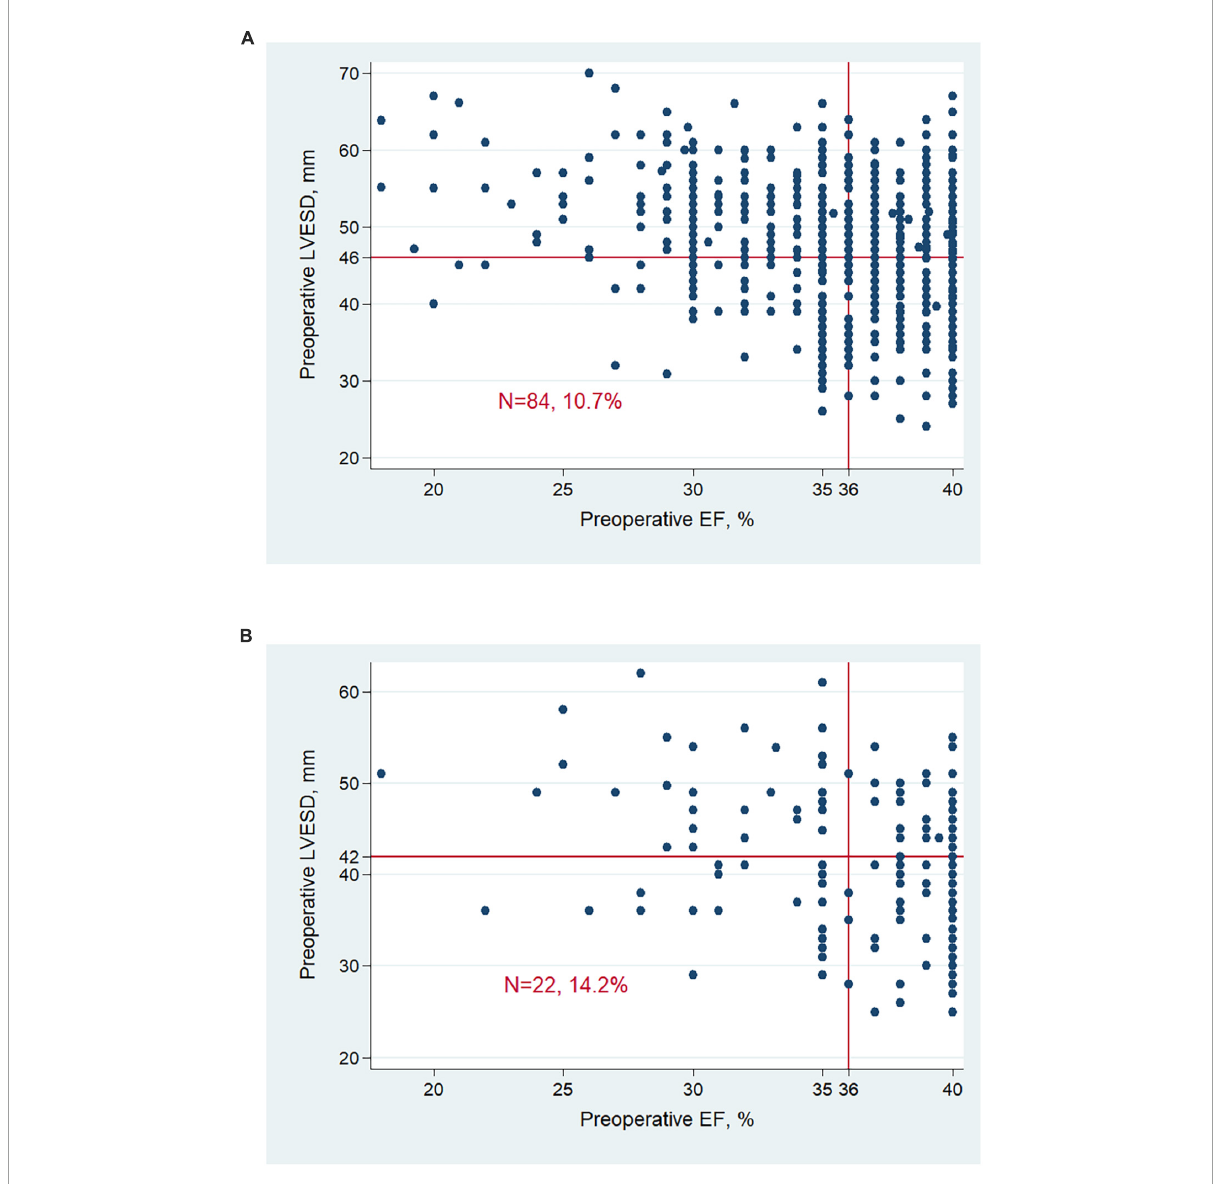
FIGURE3 Patient distribution according to LVESD and EF at baseline in men (A) and women (B) . Men with LVESD ≥ 46 mm and women with LVESD ≥ 42 mm were defined as severely enlarged LVESD. LVESD, left ventricular end-systolic diameter; EF, ejection fraction.